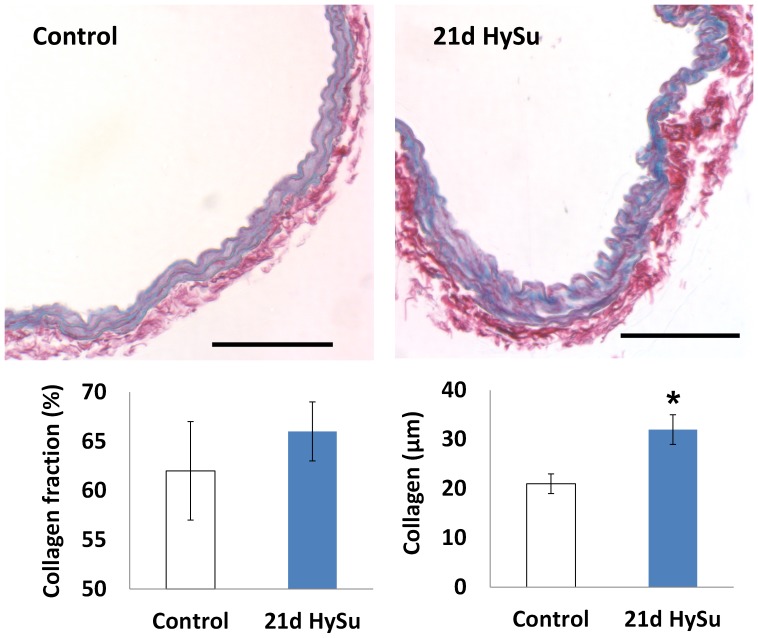
Sirius red staining for collagen (red) in control and 21d HySu PAs.Scale bar  =  100 µm. Collagen fraction area (%) tended to increase and total collagen thickness was increased in 21d HySu PAs. N  =  6 per group. Means ± Standard Errors * p<0.05 vs. control.